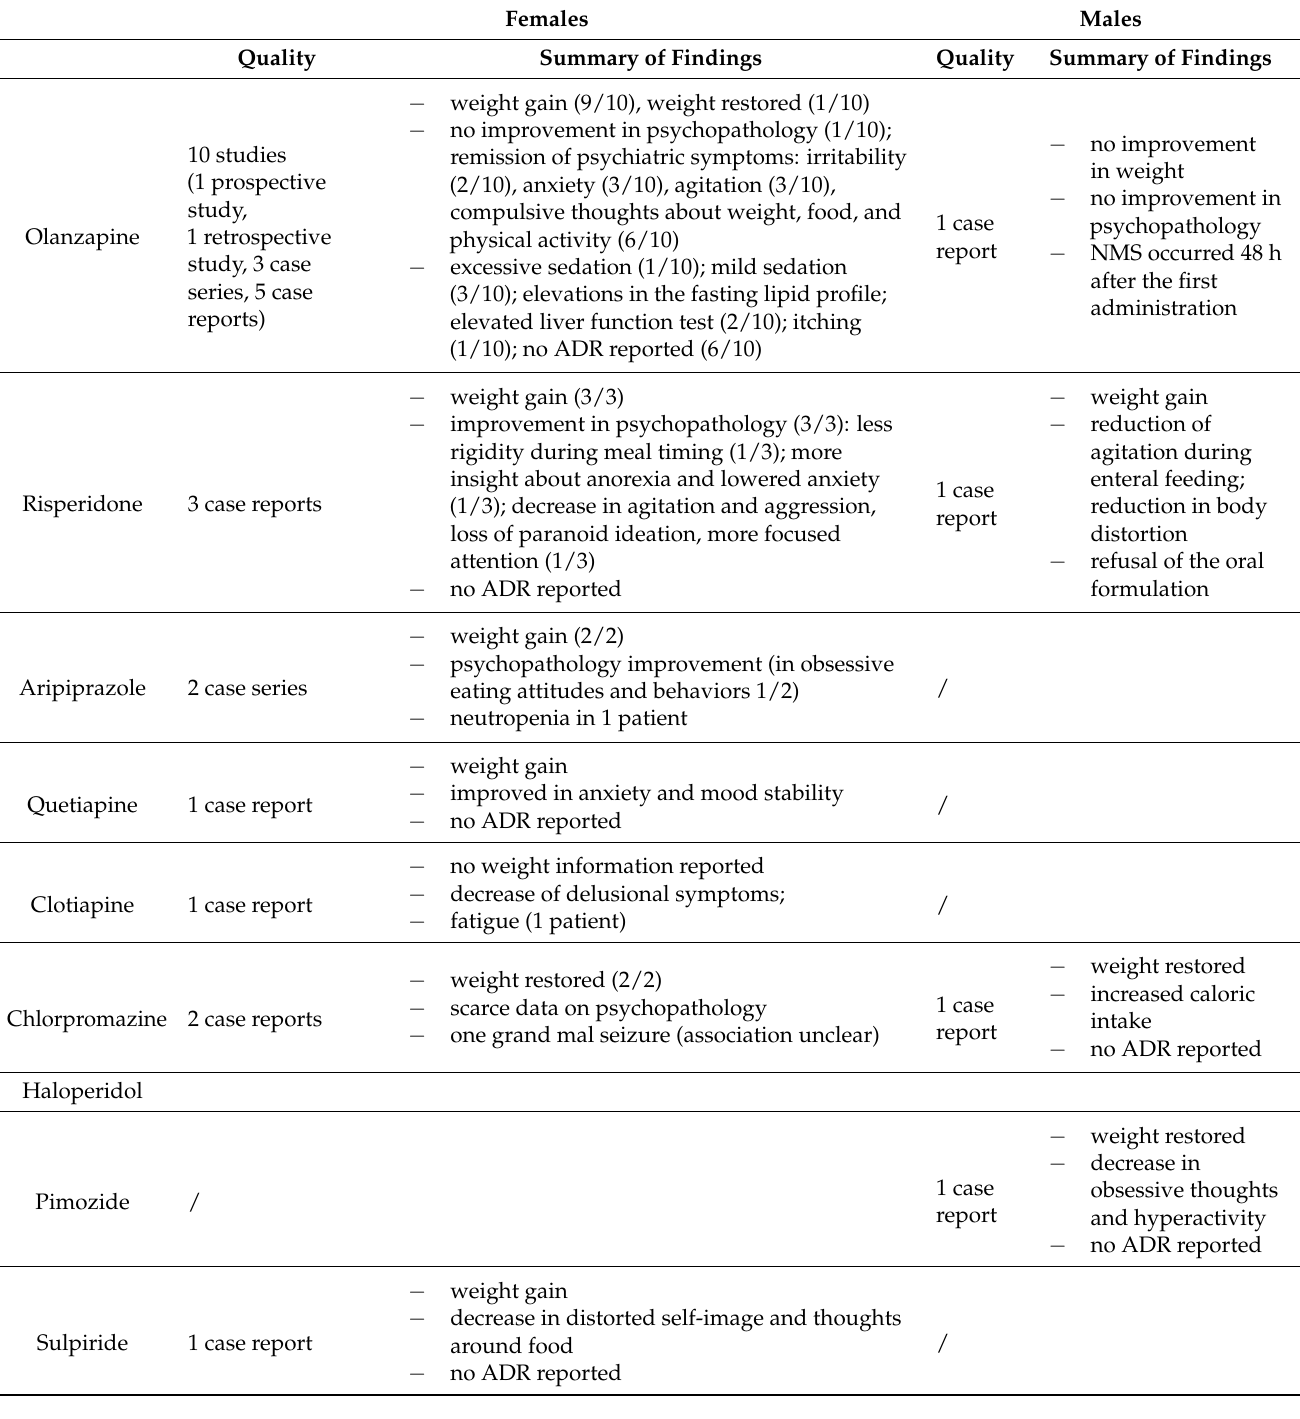
Table 3. Available evidence for female and male patients. Females Males Quality Summary of Findings Quality Summary of